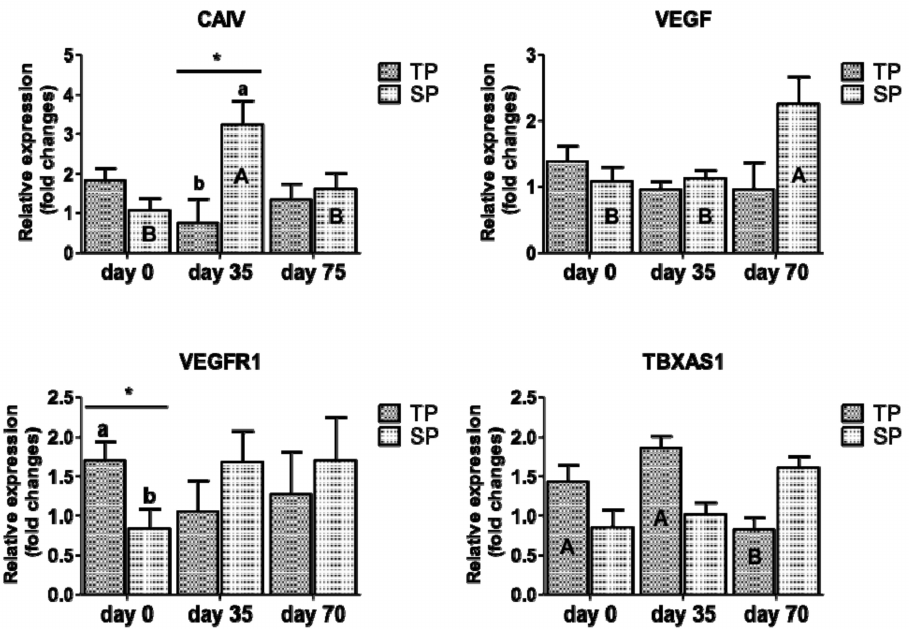
Figure 1. Relative expression of CAIV, VEGF, VEGFR1 and TBXAS1 associated to angiogenesis in the mammary gland of twin- and single bearing ewes according to time (LSM ± SEM). TP: twin-bearing ewes (n = 6); SP: single-bearing ewes (n = 7); CAIV: Carbonic Anhydrase IV; VEGF: vascular endothelial growth factor A; VEGFR1 (FTL1): fms-related tyrosine kinase 1; TBXAS1: thromboxane A synthase. Day 0: birth, day 35: day 35 post-partum and day 70: day 70 post-partum; di ff erent small letters (a,